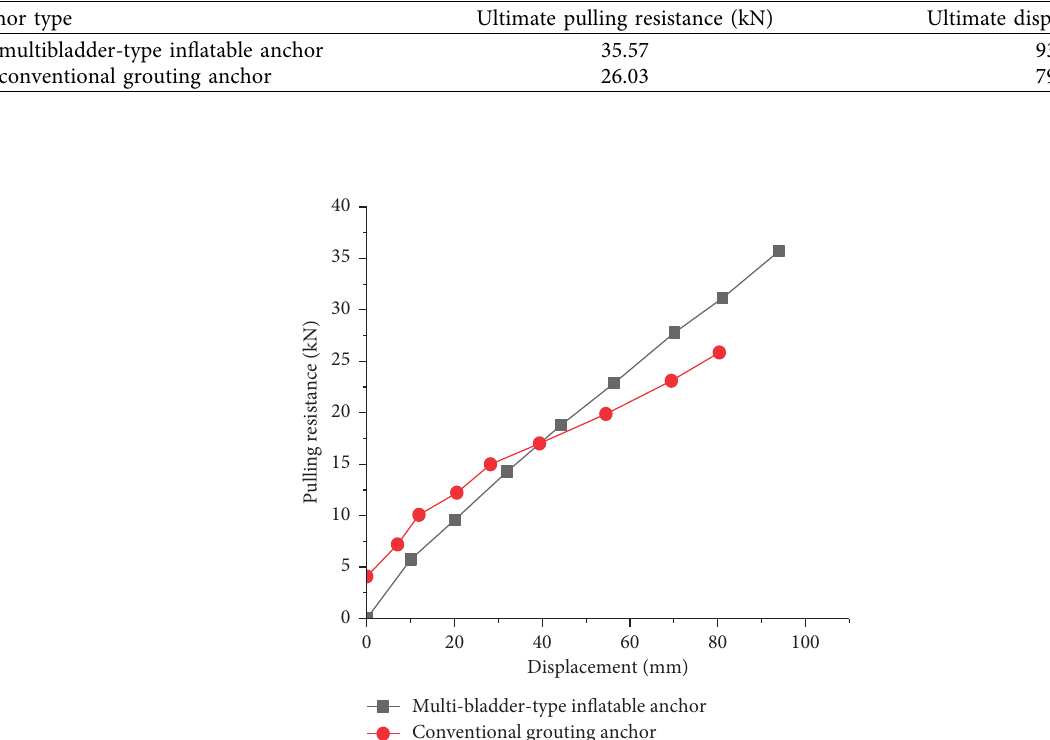
Table 4: Comparative result of bearing characteristics between the multibladder-type inflatable anchor and conventional grouting anchor. Anchor